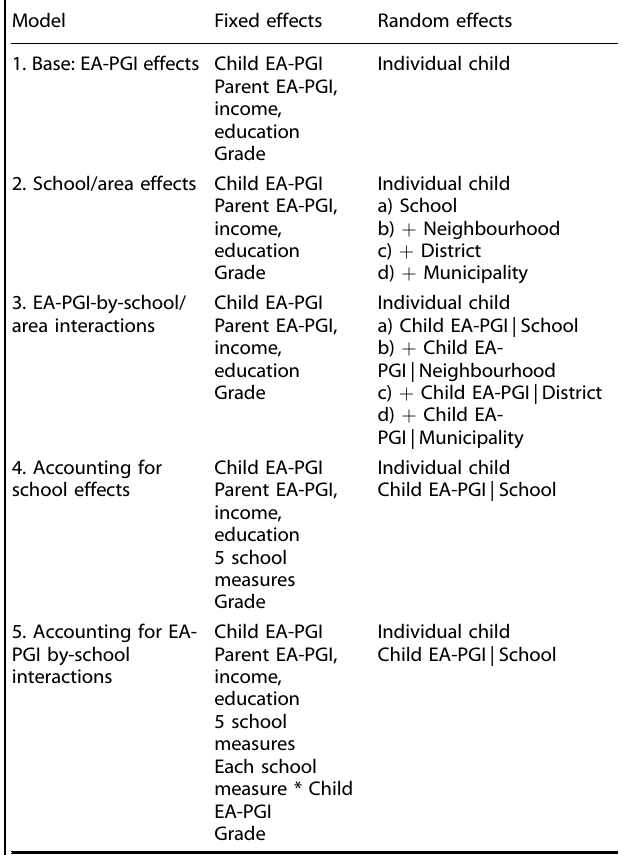
Table 1. Model- fi tting